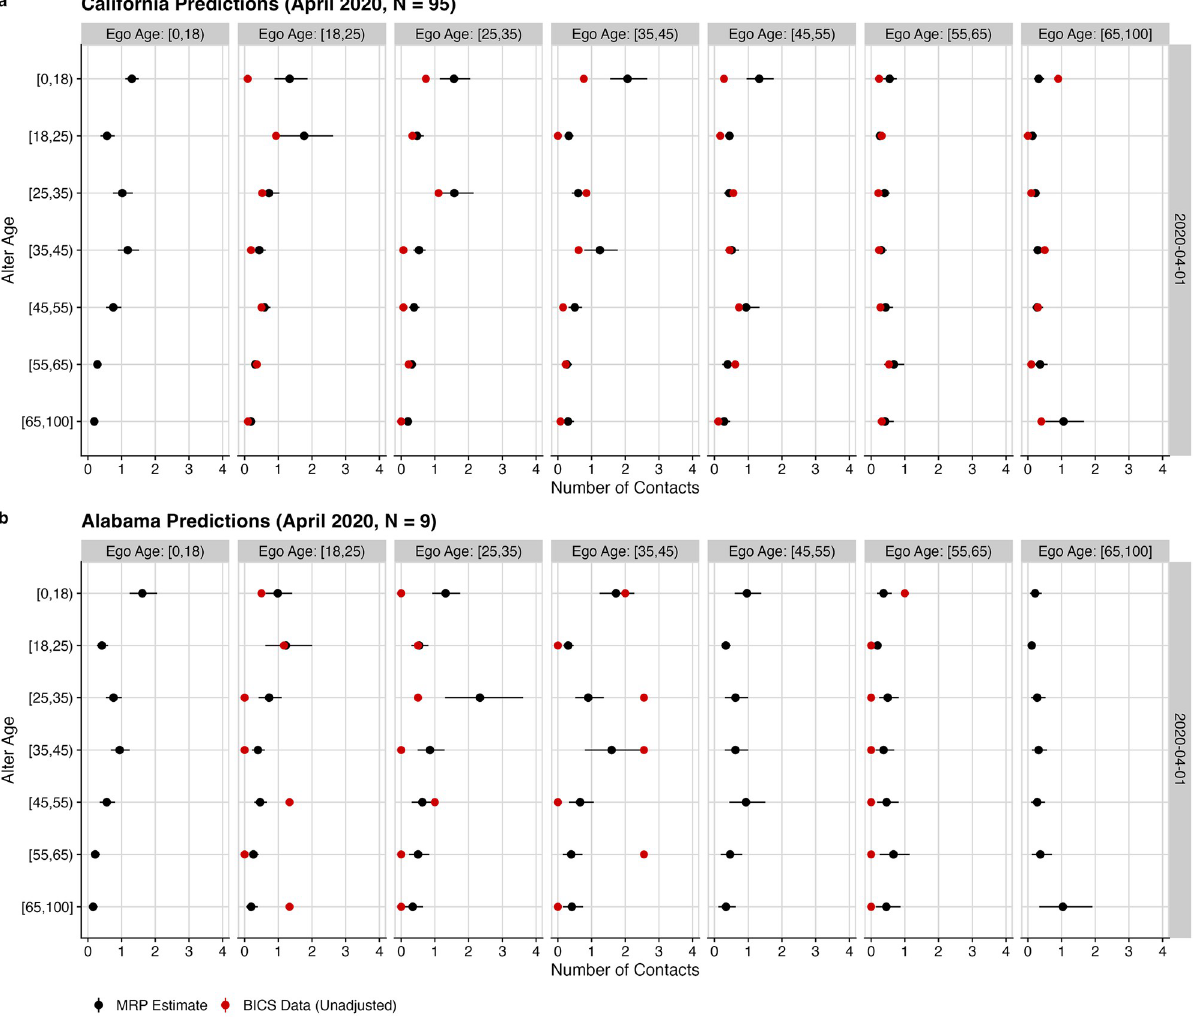
Fig 1. Comparison of MRP-adjusted estimates (black) with unweighted BICS estimates for Alabama (panel A) and California (panel B) from April of 2020. MRP estimates are presented with 95% credible intervals. Where more data are available, predictions more closely track original survey